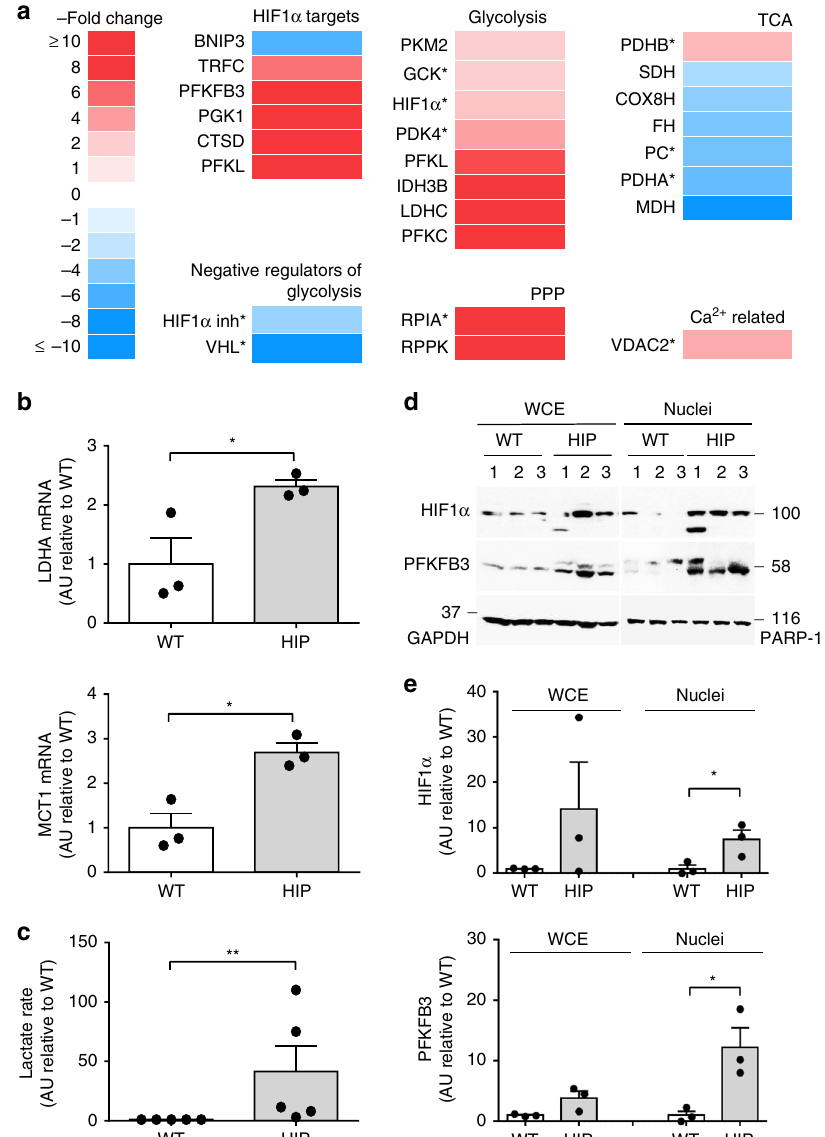
Fig. 1 hIAPP upregulates the HIF1 α /PFKFB3 stress pathway. a Summary of the differentially expressed genes of interest after microarray analysis 25 performed on RNA isolated from wild type (WT) and hIAPP overexpressing (HIP) rat islets (4.5 months) presented as a fold change over WT. Asterisk represents genes that were differentially expressed in one experiment. b LDHA and MCT1 mRNA levels in HIP versus WT as measured by qRT-PCR. c Lactate production rate (fold change) measured in isolated islets from HIP relative to WT. d Representative Western blot of PFKFB3 and HIF1 α protein levels in whole cell extracts and nuclear-enriched fractions of islets from 6 months old WT (3) and HIP (3) rats. GAPDH and PARP were used as loading controls for whole cell extract (WCE) and nuclear extracts, respectively. e Quanti fi cation of HIF1 α (upper panel) and PFKFB3 (lower panel) in cytoplasmic and nuclear fractions. Data are presented as mean ± SEM, n = 3 independent experiments for ( b ) and ( d ), and n = 4 independent experiments for ( c ). Statistical signi fi cance was analyzed by Student t -test (* p < 0.05, ** p <